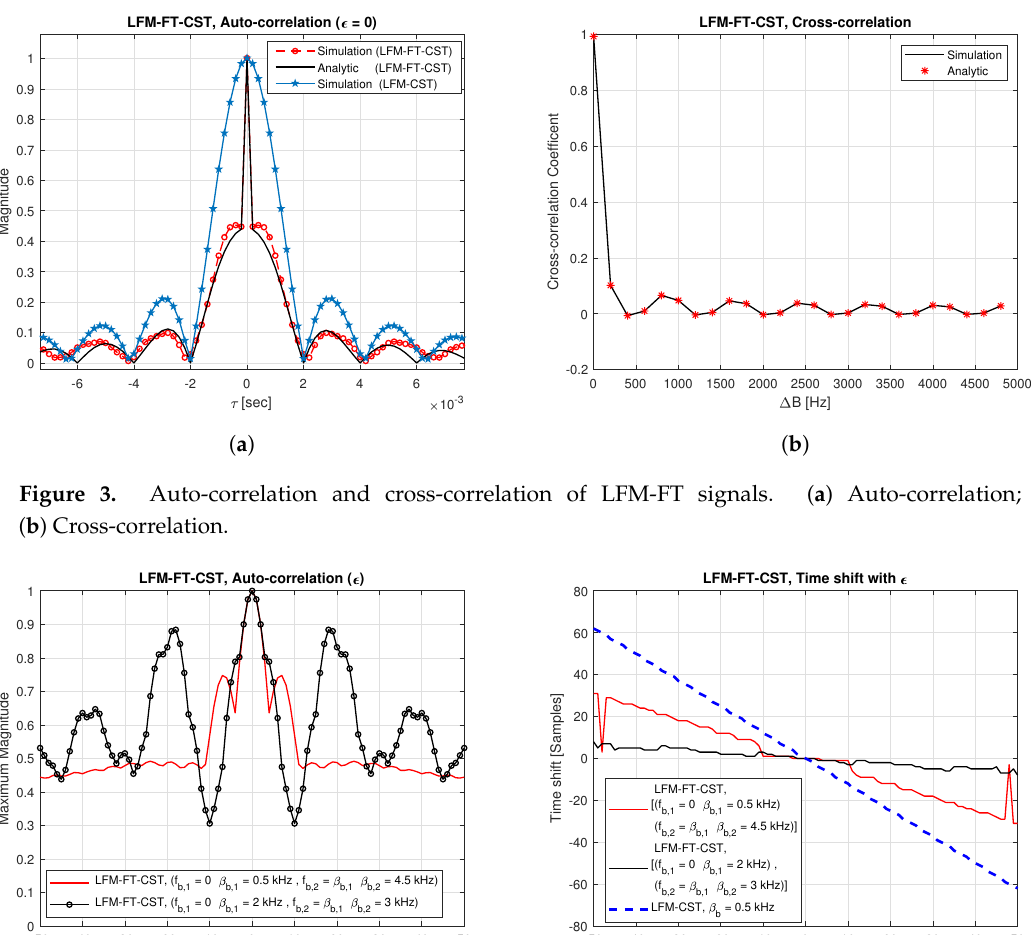
Figure 2. Instantaneous frequencies of LFM-FT signals for multiple cell IDs (CIDs). ( a ) Multiple CIDs; ( b ) Two CIDs.